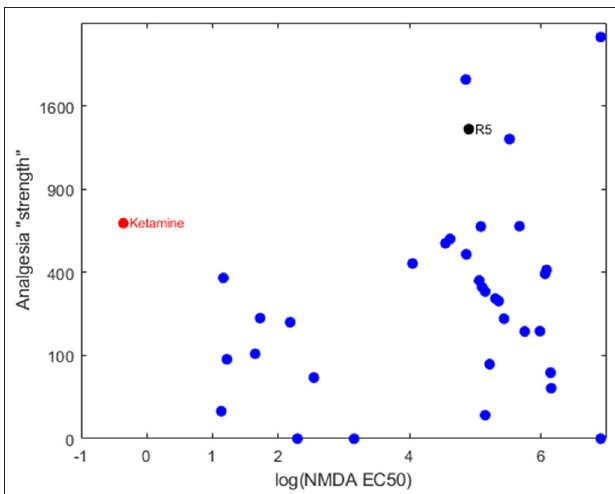
FIGURE 1 | Bi-logarithmic plot of NMDA binding (EC50) vs. analgesia for a series of ketamine analogs. The red dot is the parent ketamine, the black dot is R5 and the blue dots are other ketamine-ester variants. There is no correlation, suggesting that NMDA has a negligible role in production of analgesia for these compounds. Determination of NMDA inhibition was carried out by commercial provider (Eurofins Panlabs Taiwan, Ltd. Pharmacology Laboratories) according to reported procedure ( 7). MK-801 {[5 R ,10 S ]-[ + ] -5-methyl-10,11-dihydro-5 H -dibenzo [ a , d ]cyclohepten-5,10-imine}, Ketamine and ketamine analogs were tested for competitive binding against the radioligand 5nM [ 3 H]-MK-801 in wistar rat brain preparations, incubated in 5mM Tris-HCL at pH 7.4 for 3h at 25 ◦ C. Radioligand displacement was used to determine ligand binding affinity to calculate IC 50